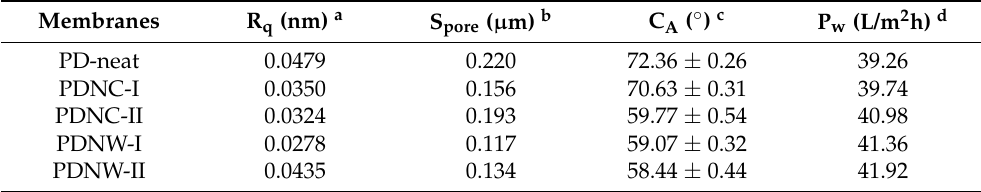
Table 1. Surface roughness, porosity, contact angle and water permeability data of membrane samples.